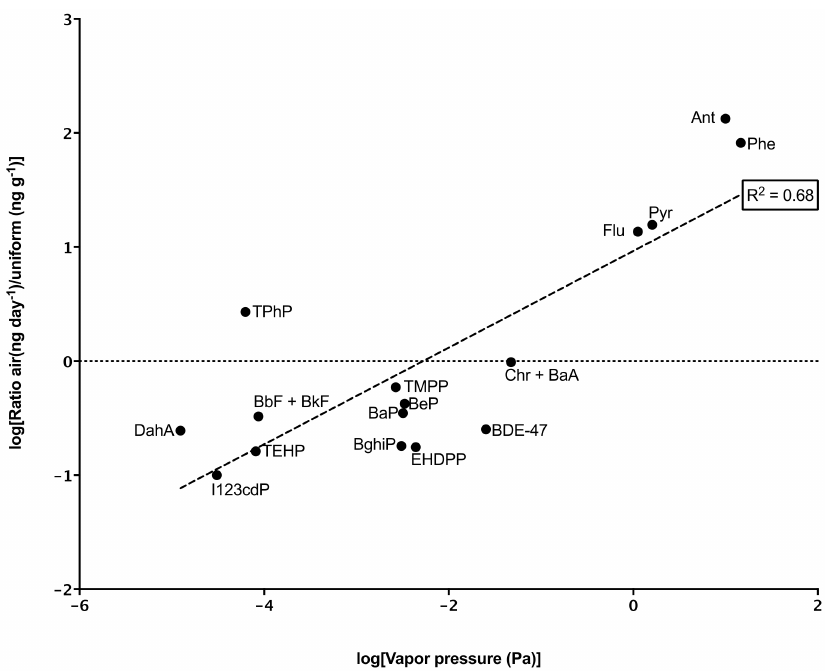
Figure 3. Relationship between vapor pressure and the rate at which semi-volatile organic com- pounds (SVOCs) off-gassed from a structural firefighting uniform in a